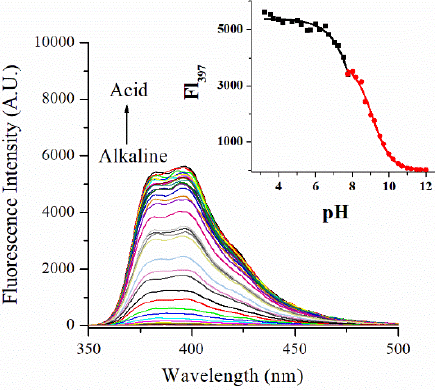
Figure 2. Fluorescent spectra of probe 4 in 100% aqueous solution in a pH-interval 2–12 ( λ ex = 340 nm). Inset: pH titration plot of the probe 4 fluorescence intensity at 397 nm.